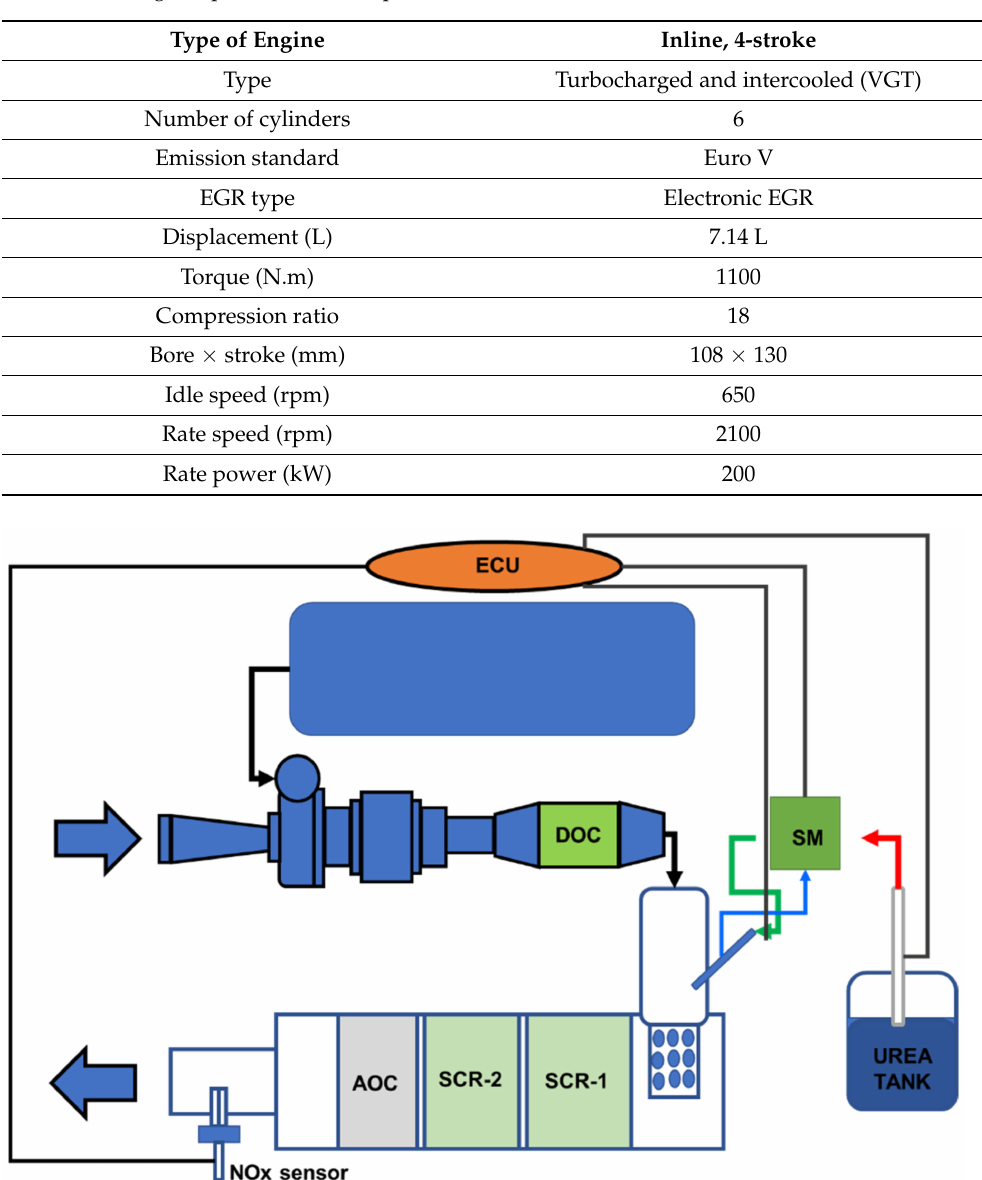
Figure 26. Schematic of the experimental setup for the 7100 cc diesel engine